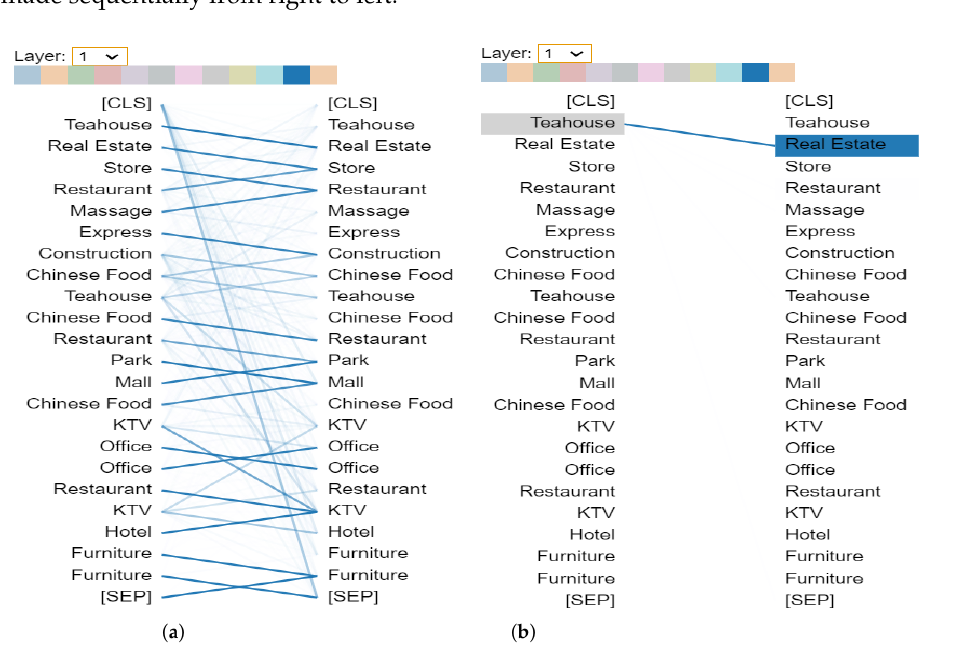
Figure 12. The pattern of attention to the next token. The attention mechanism for shortest